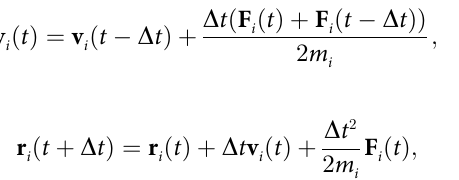
( C ) is a list of all the charged particles in cell C ele k